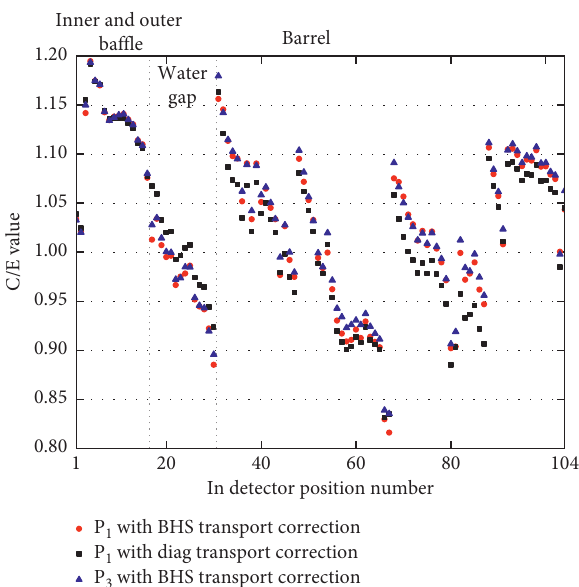
Figure 24: Comparison of P 1 transport correction with P 3 results of the